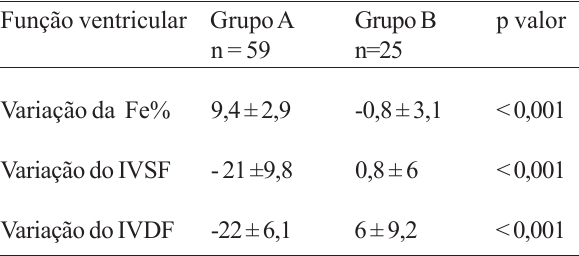
Tabela 2. Variação da fração de ejeção e volumes ventriculares após revascularização nos grupos A e B.